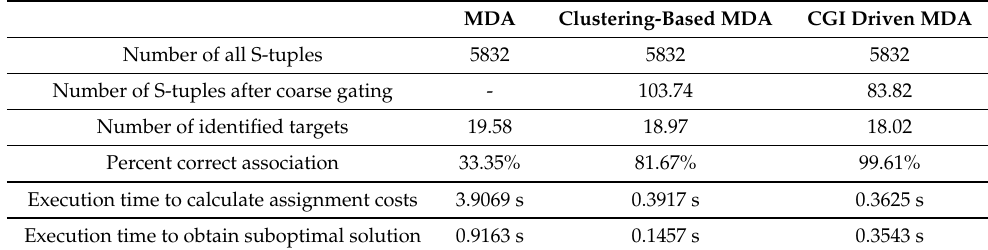
Table 3. The performance comparison of different